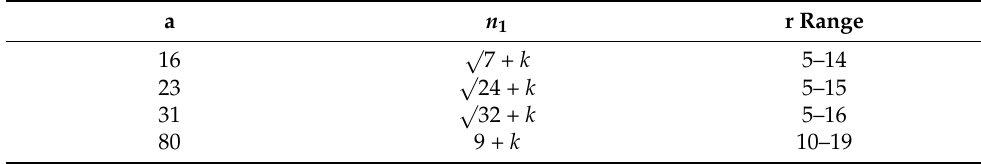
Table 10. Calculation of the layer neurons.